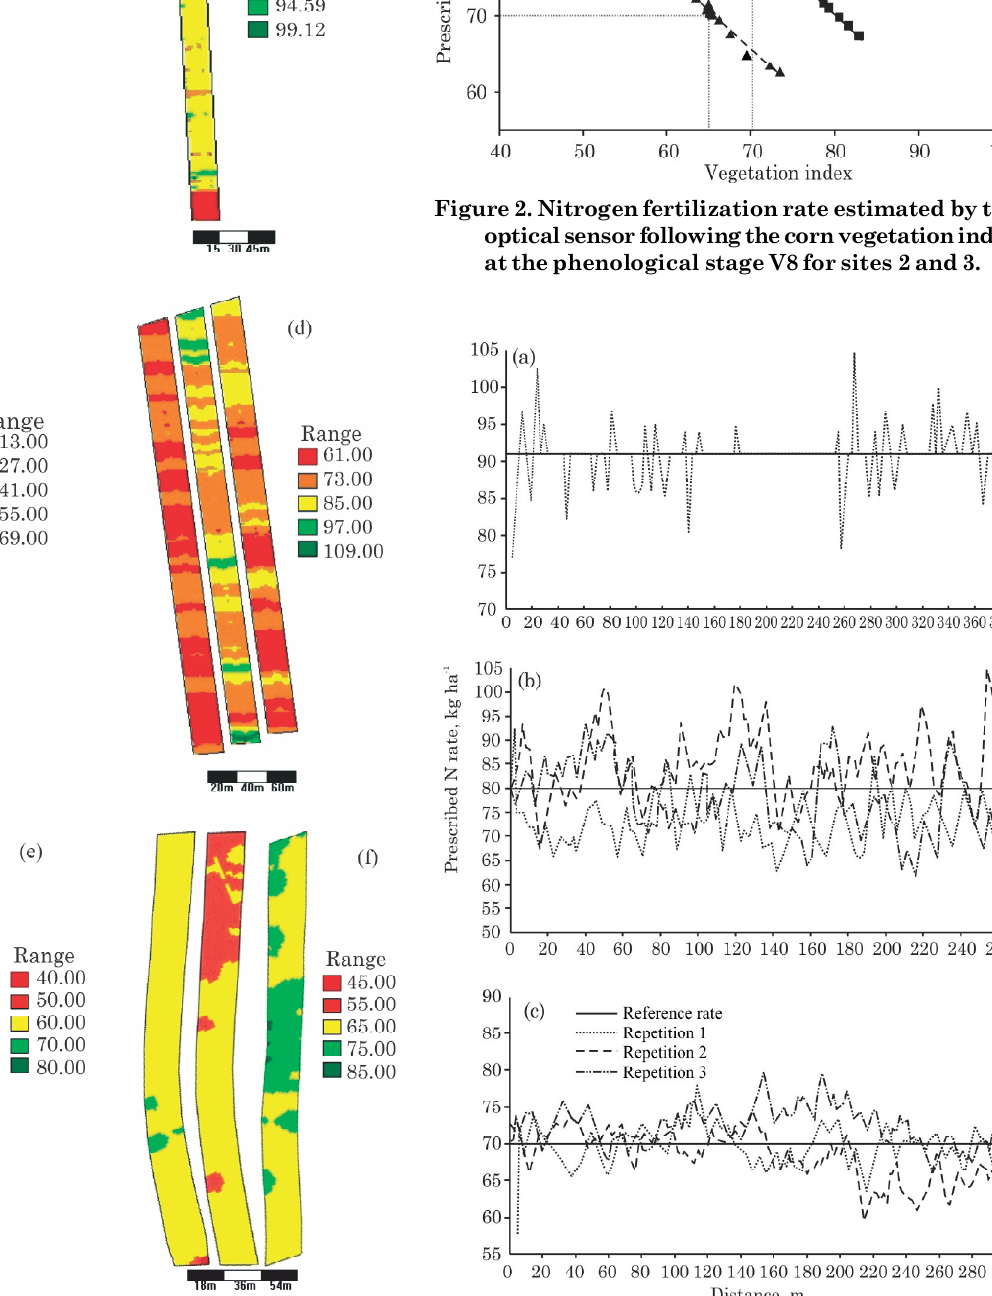
Figure 3. Variable nitrogen fertilization rates estimated by the optical sensor and the reference rate for (a) site 1 (91 kg ha -1 ), (b) 2 (80 kg ha -1 ), and (c) 3 (70 kg ha -1 ).